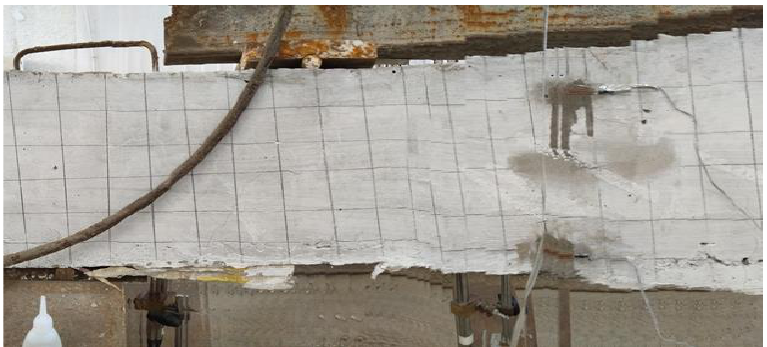
Figure 6. Strain gauge placement.